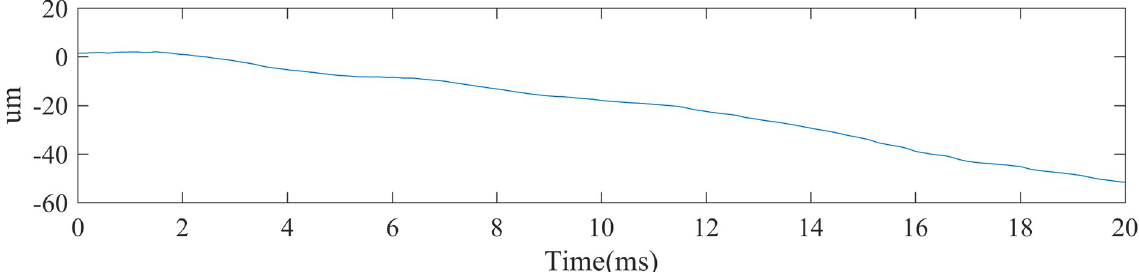
Fig 11. Displacement signal demodulated from noise-free